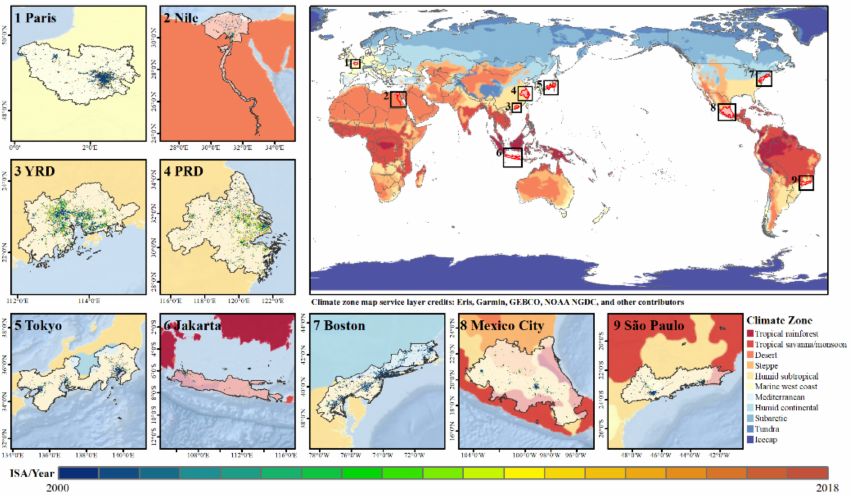
Figure 1. The 9 mega-regions selected and their built-up (BU) areas from 2000 to